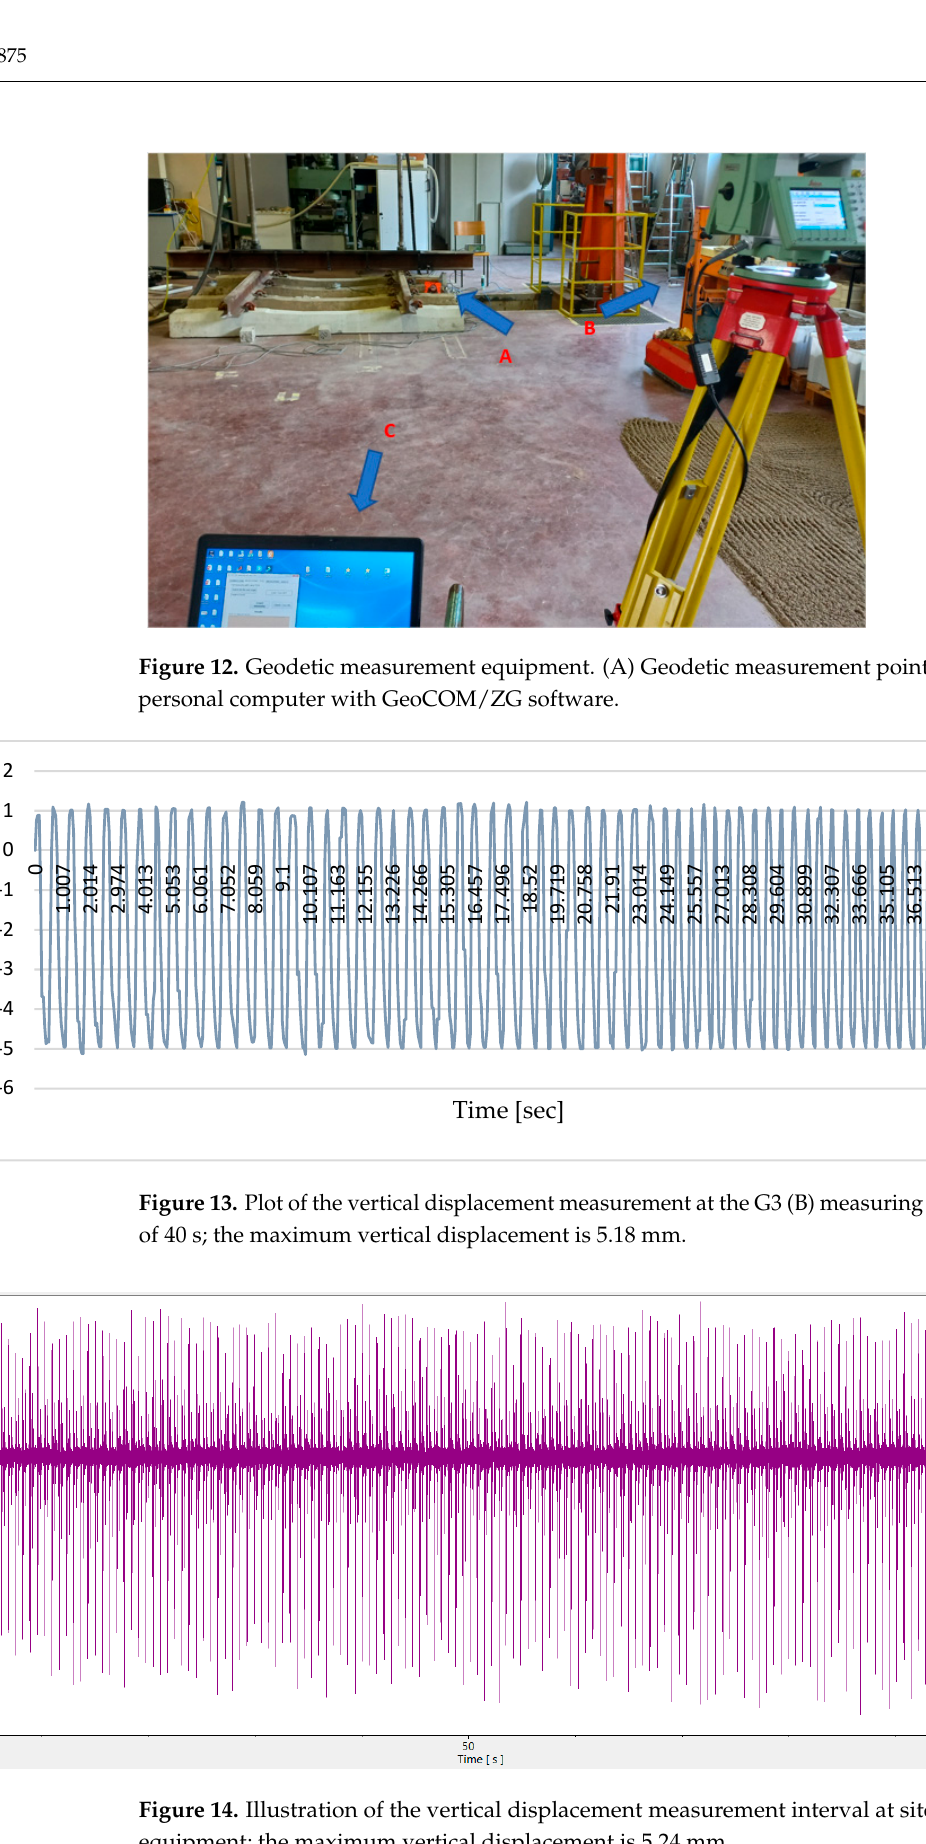
Figure 14. Illustration of the vertical displacement measurement interval at site G1 (B) with SLDV equipment; the maximum vertical displacement is 5.24 mm.